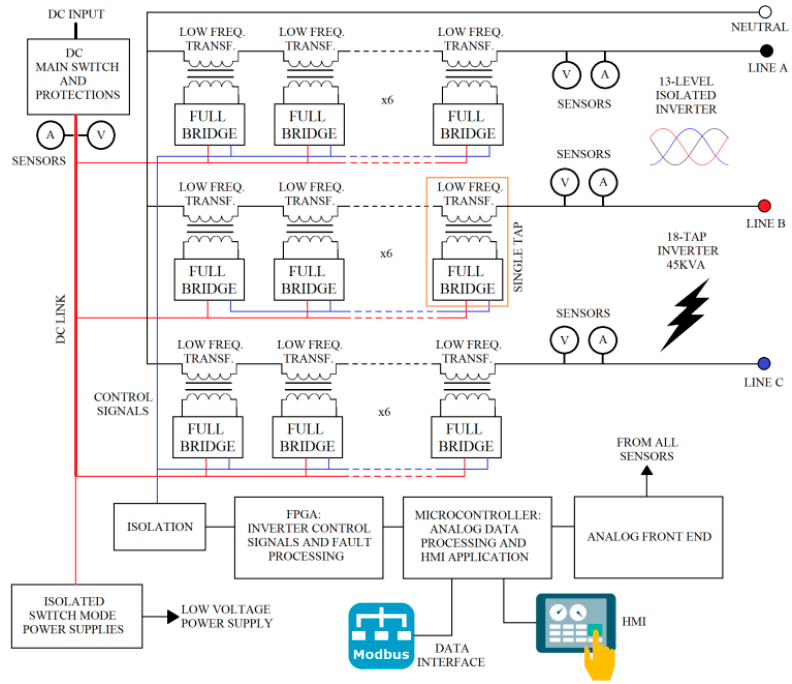
Figure 4. A 45kVA AC-side-isolated modular CTMI. Each output line contains six stages to perform a 13-level inverter.